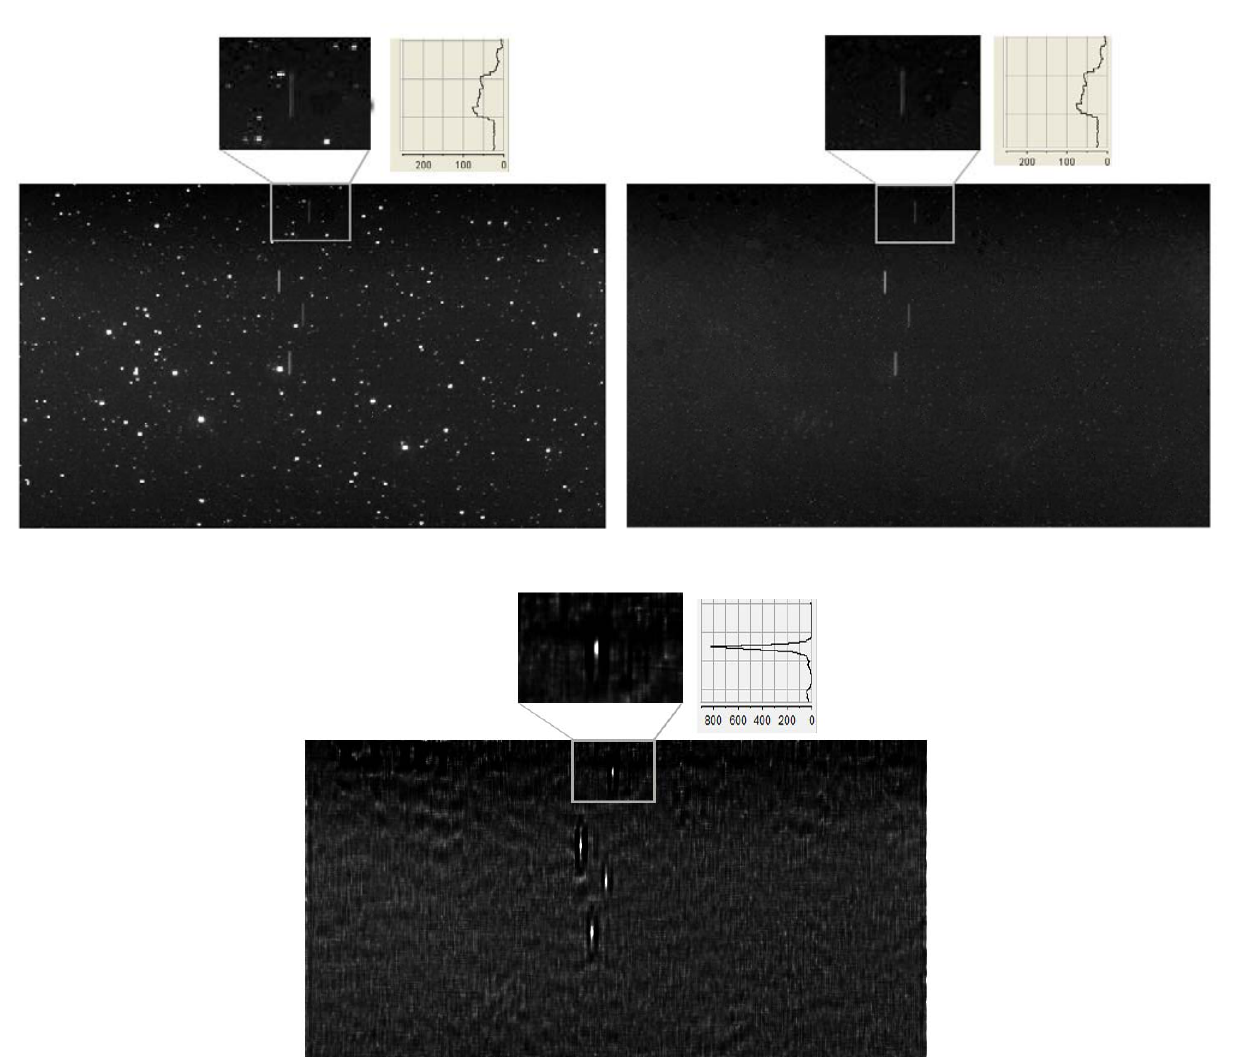
Figure 5. CCD image of a group of satellites (upper left). The same image with most of its stars removed (upper right). AWMLE deconvolution of upper right image using the brightest satellite trail as PSF (lower panel). All three panels are displayed using the same grey scale distribution. Note the high improvement in detectability of the faintest satellite (compare upper with lower zoomed panels). The light profiles show a large increase in the SNR of the deconvolved image with respect the original